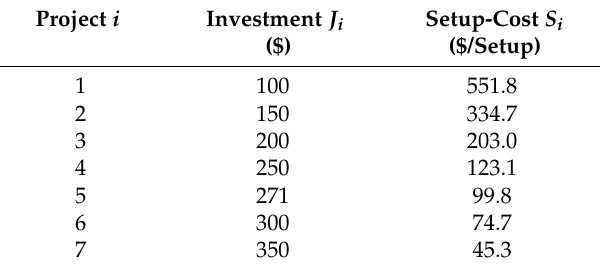
Table 1. Investment data for setup cost